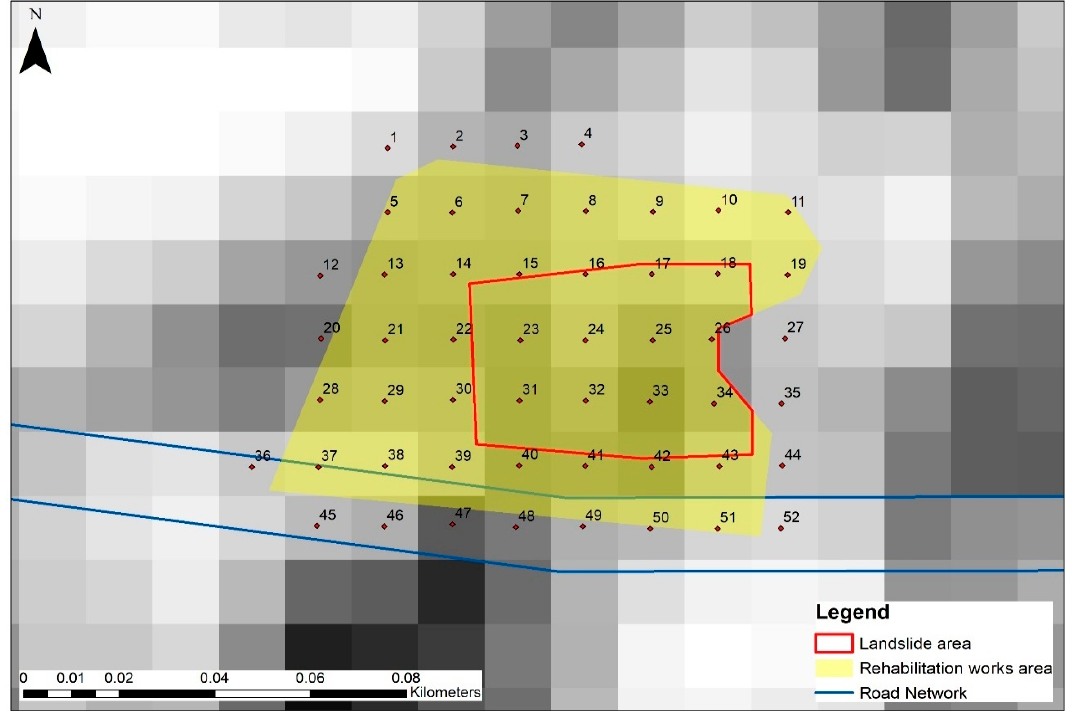
Figure 11. Coherence map – Point grid. The entire area where rehabilitation works took place (in yellow) consists of 52 pixels, 20 of which lie within the boundaries of the area affected by the landslide.